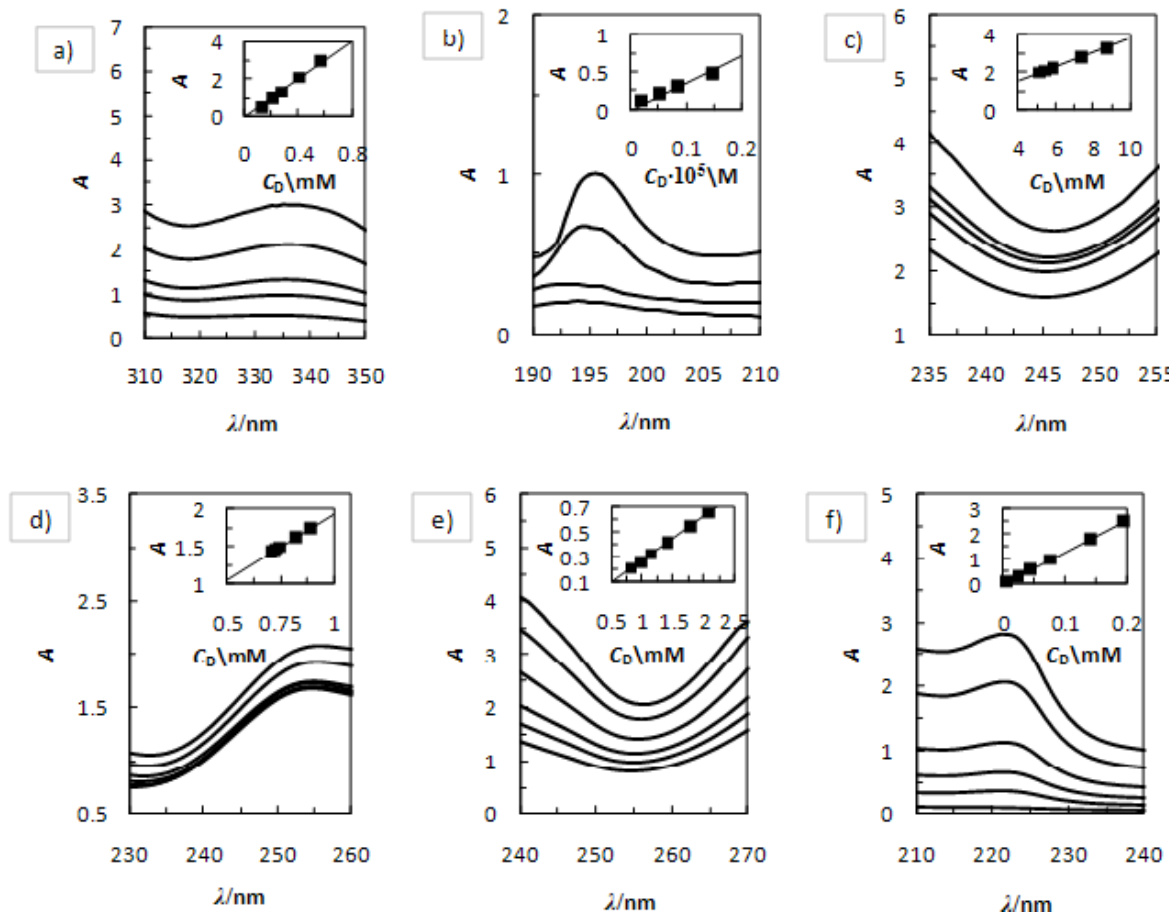
Figure 1. Absorption spectra of different concentrations of drugs at T = 298.15 K and their calibration curves. ( a ) Mefemamic acid, phosphate buffer I (pH 7.0); ( b ) Mefemamic acid, phosphate buffer II (pH 2.0); ( c ) Niflumic acid, phosphate buffer I (pH 7.0); ( d ) Niflumic acid, phosphate buffer II (pH 2.0); ( e ) Flufenamic acid, phosphate buffer I (pH 7.0); ( f ) Flufenamic acid, phosphate buffer II (pH